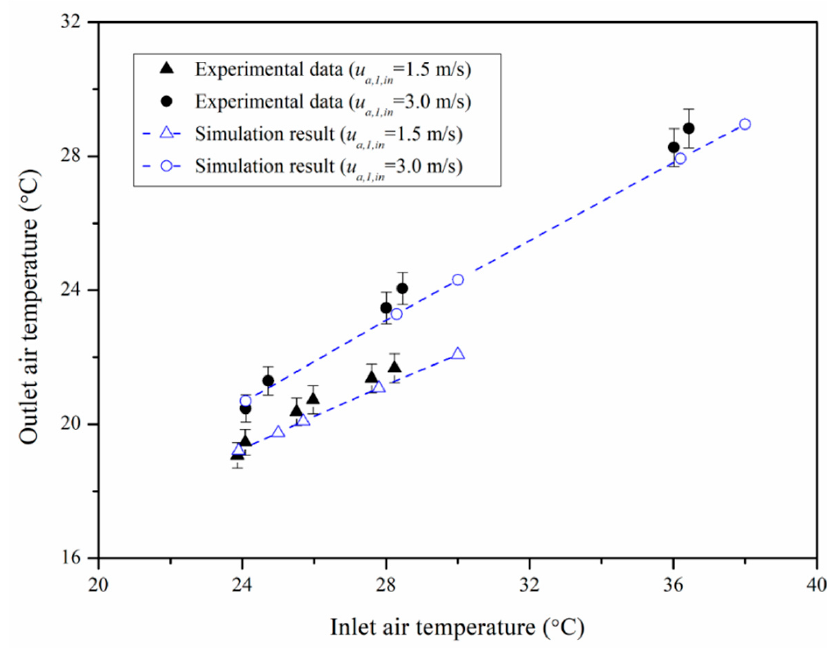
Figure 3. Validation 1: Outlet air dry bulb temperature of a counter-flow regenerative